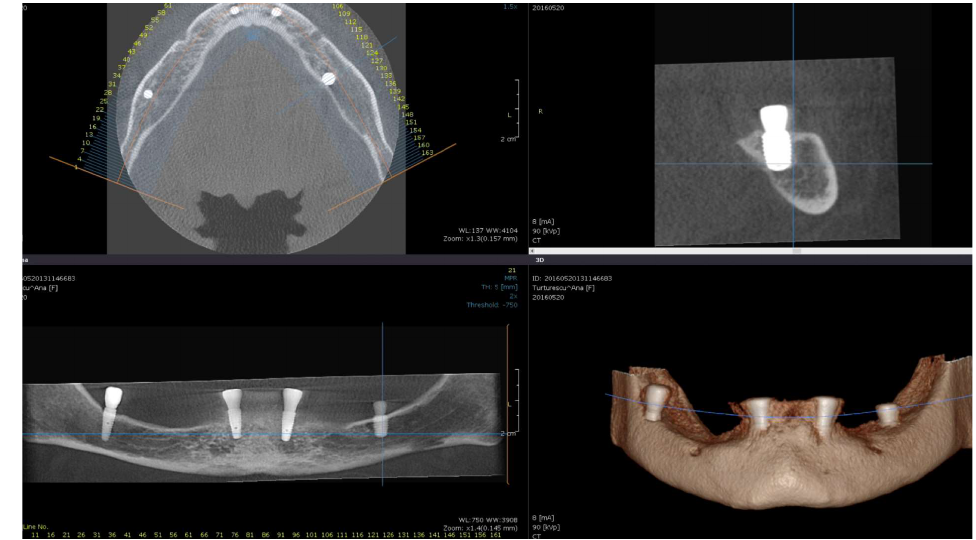
Figure 2. Postoperative CBCT of patient no. 5: ( Upper left )—axial view of the mandible; ( upper right )—sagittal left view of the lingually tilted implant (36); ( lower left )—coronal view of the mandible; ( lower right )—3D view of the mandible.